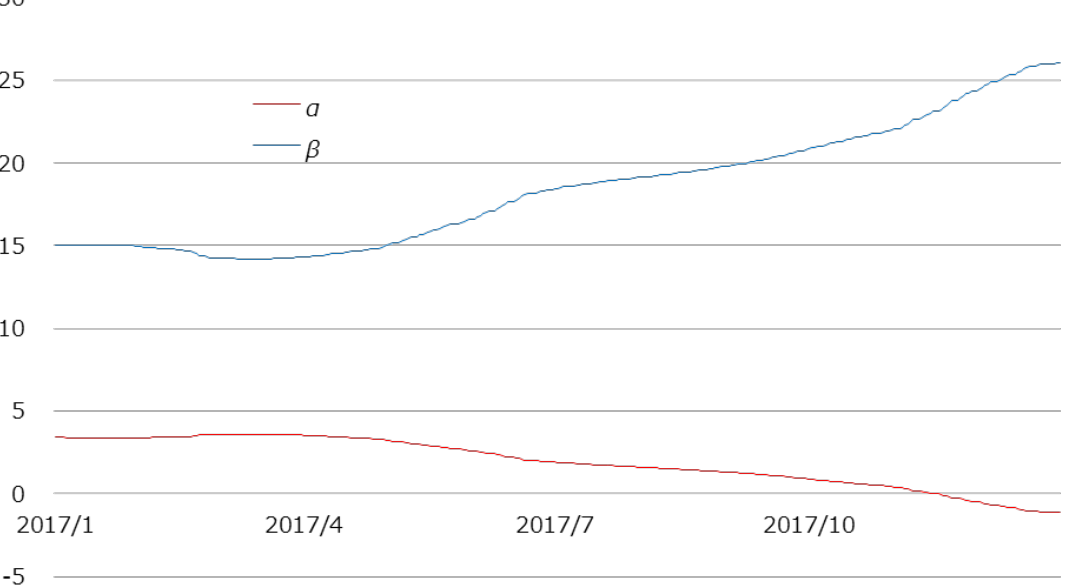
Figure 5. Coefficients of equilibrium equation.